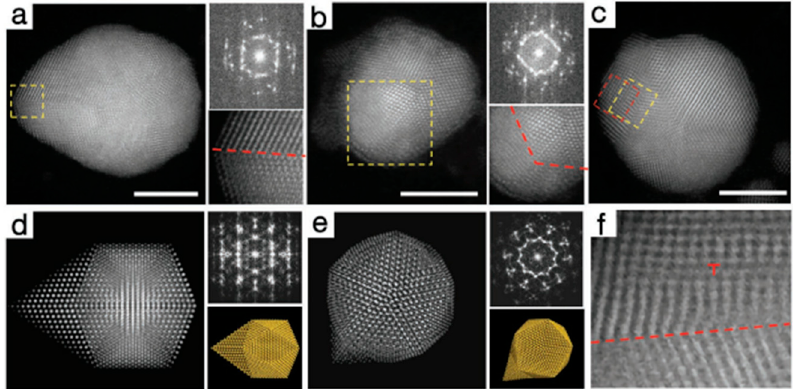
Figure 3. Structural characterization of line defects in symmetry − breaking Au icosahedral catalysts. HAADF − STEM images, FFT patterns and magnified image of the selected area projected close to ( a ) [112] and ( b ) [110] direction. ( c ) HAADF–STEM image of an initial Au structure. STEM image simulation, FFT patterns and atomic structure models projected along ( d ) [112] and ( e ) [110] directions. ( f ) Enlarged view of the selected area in ( c ). Scale bars are 5 nm. Reproduced with permission [38]. Copyright 2020,